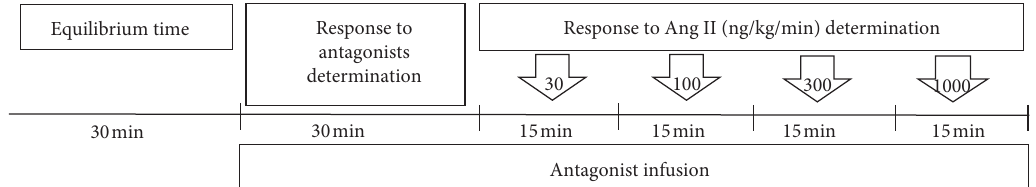
Figure 1: The protocol of experimental study (see Section